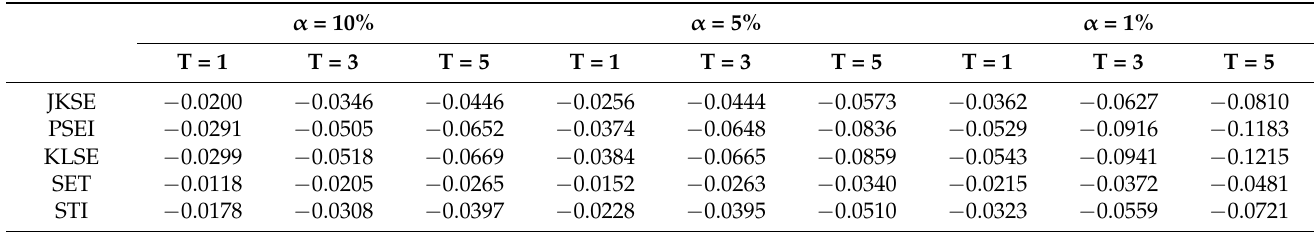
Table 11. VaR-VC risk prediction results at various confidence levels and holding